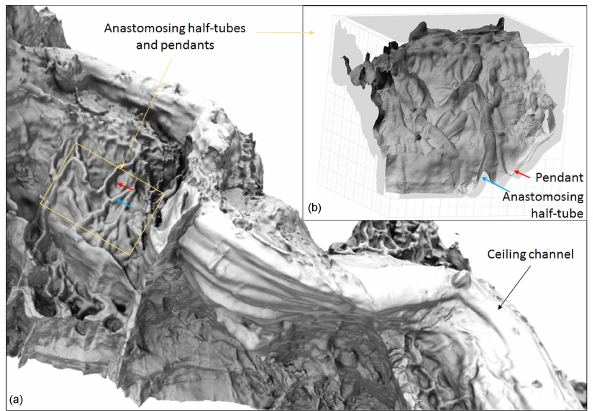
Figure 11. Ambient occlusion of the 3-D cave surface model in the Gothic Dome rendered with grey tones enhances perception of the cave surface morphology (a) . Detail view of the smaller area of the 3-D mesh (b) shows the cave walls from inside. The size of the major and minor cells in the background grid is 1 and 0.5m, respectively. The displayed mesh was generated from the original TLS data set subsampled at 1cm point spacing demonstrating the high resolution of cave